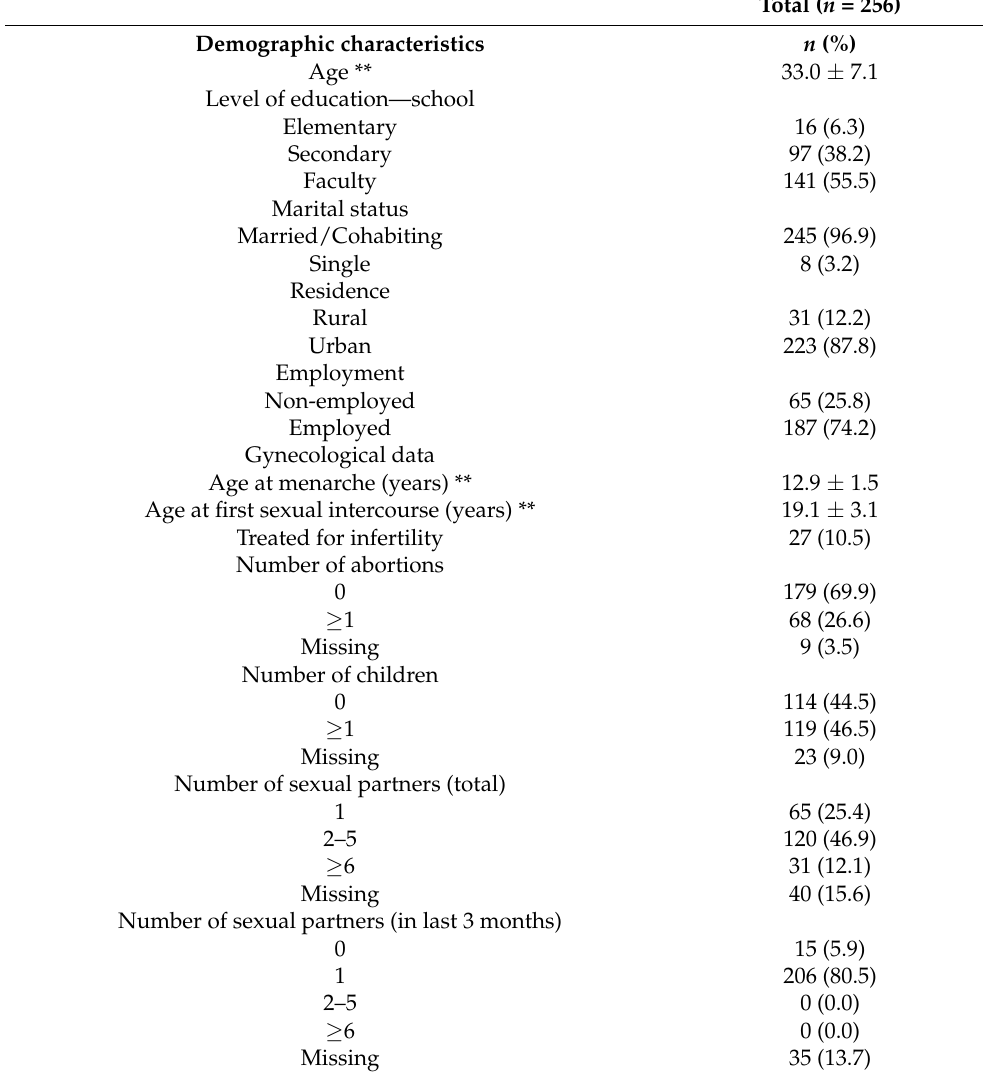
Table 1. Demographic characteristics and gynecological